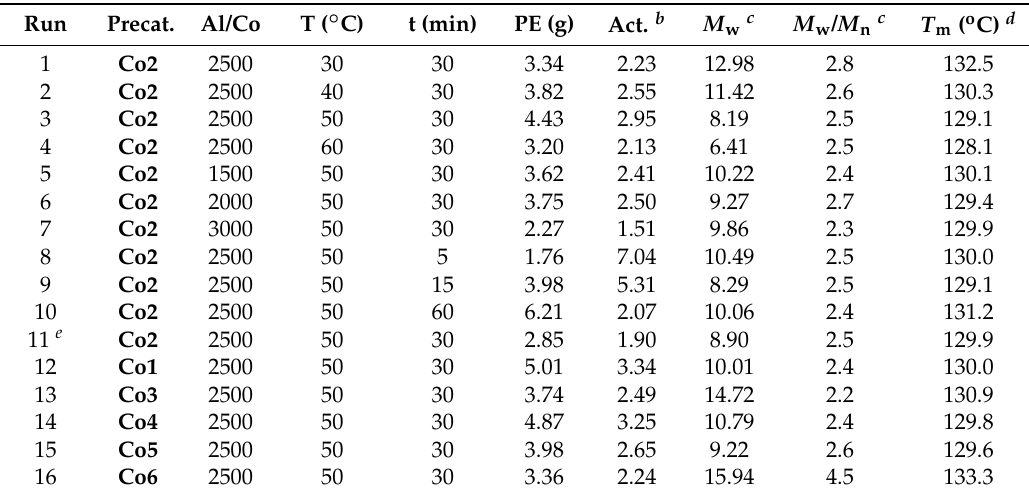
Table 3. Ethylene polymerization results using Co2 /MMAO a.